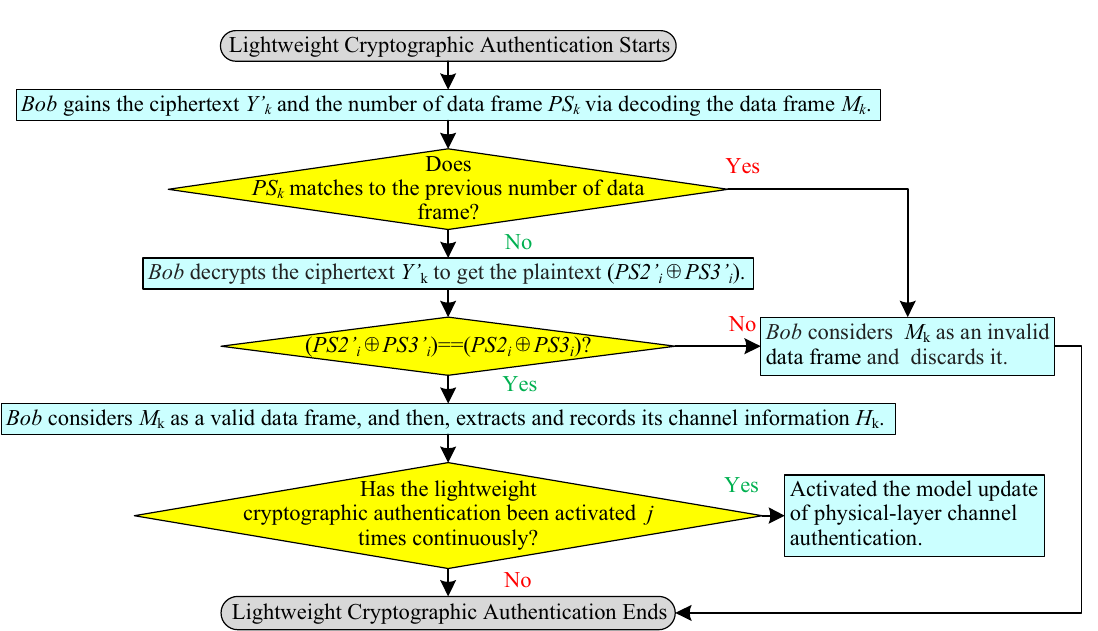
Figure 8. Process flowchart of lightweight cryptographic authentication.